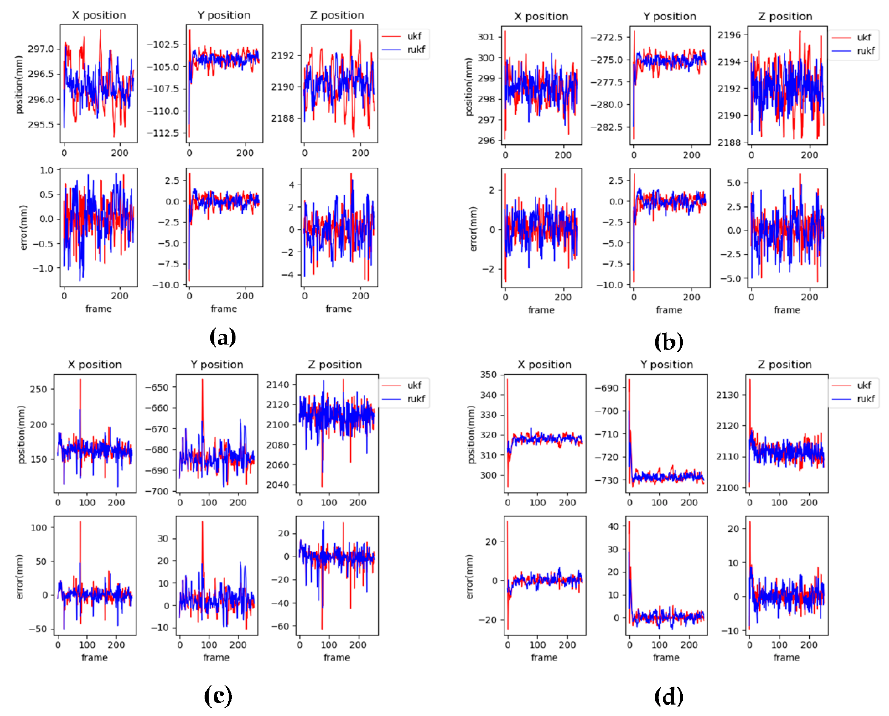
Figure 4. Comparison of the position error of joints with the UKF, and proposed method; ( a ) Pelvis, ( b ) Spine_navel, ( c ) Head, and ( d ) Nose.